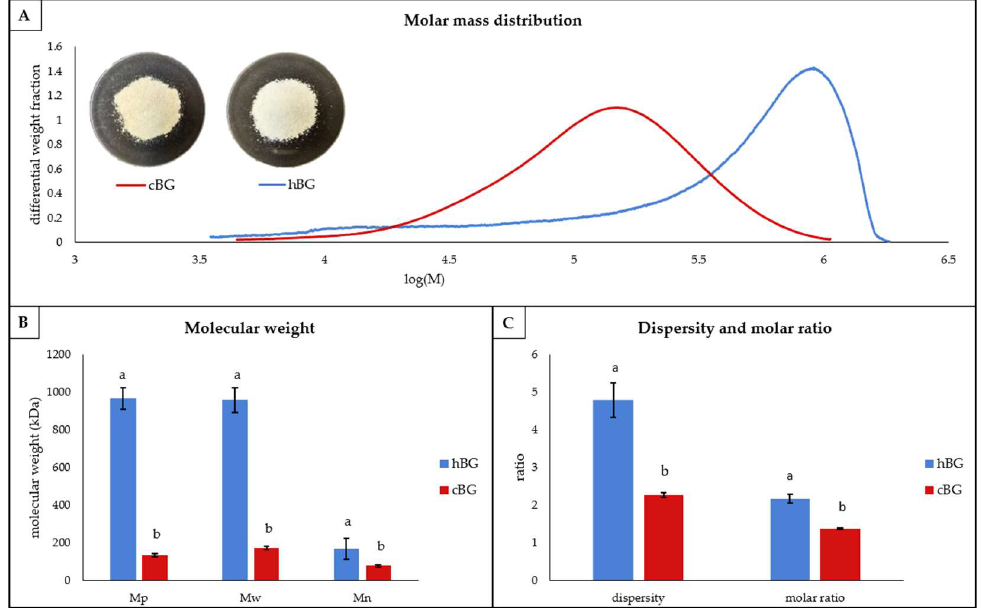
Figure 1. Structural characteristics of high molar mass and control β-glucan (hBG and cBG) presented as: ( A ) molar mass distribution shown as differential weight fraction plotted against the logarithmic molar mass (M), the pictures represent the cBG and hBG extracts; ( B ) peak- (M p ), weight average- (M w ) and number average (M n ) molar mass; ( C ) dispersity and molar ratio. All values are shown as mean ± standard deviation ( n = 3, p < 0.05). Different lower-case letters indicate a significant difference between the extracts for each characteristic.